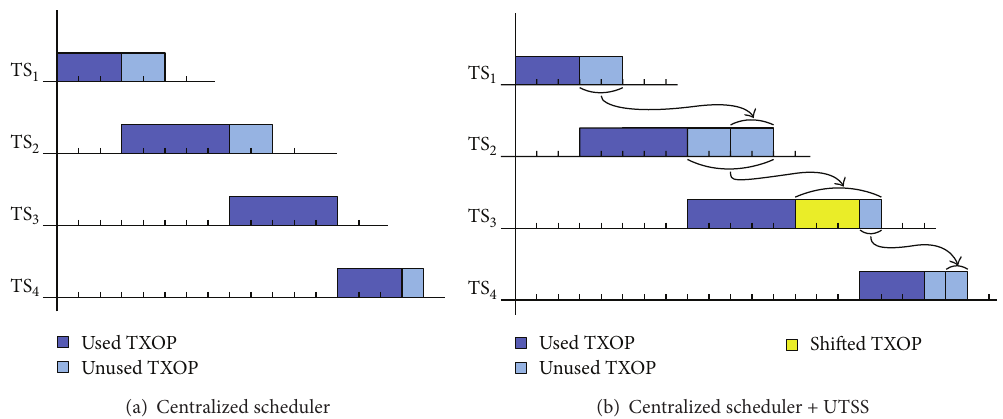
Figure 4: Scheduling